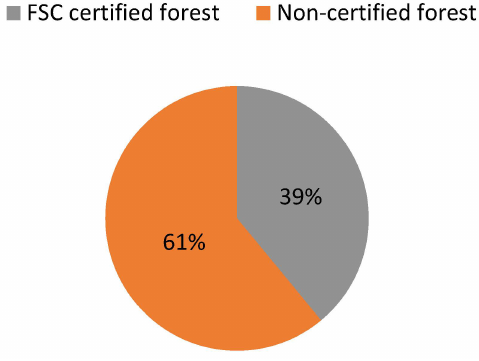
Figure 1. Certified forests in